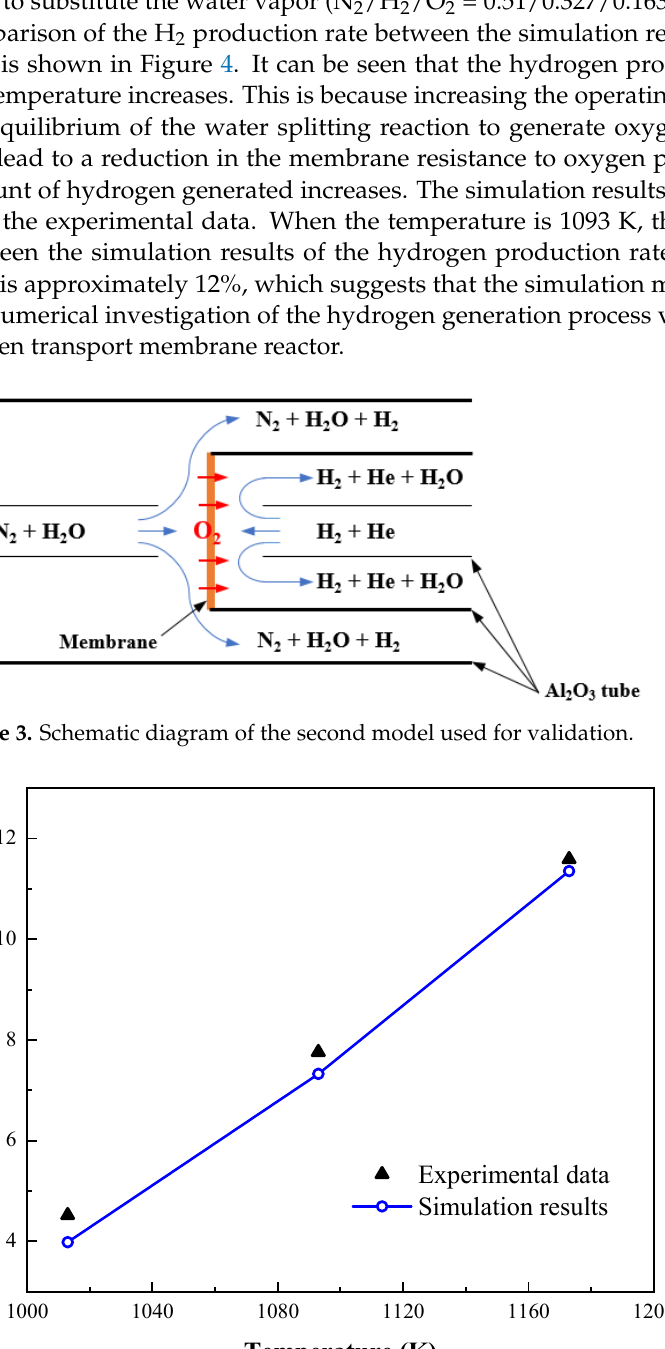
Figure 4. Comparison of H 2 production rate between simulation results and experimental data.